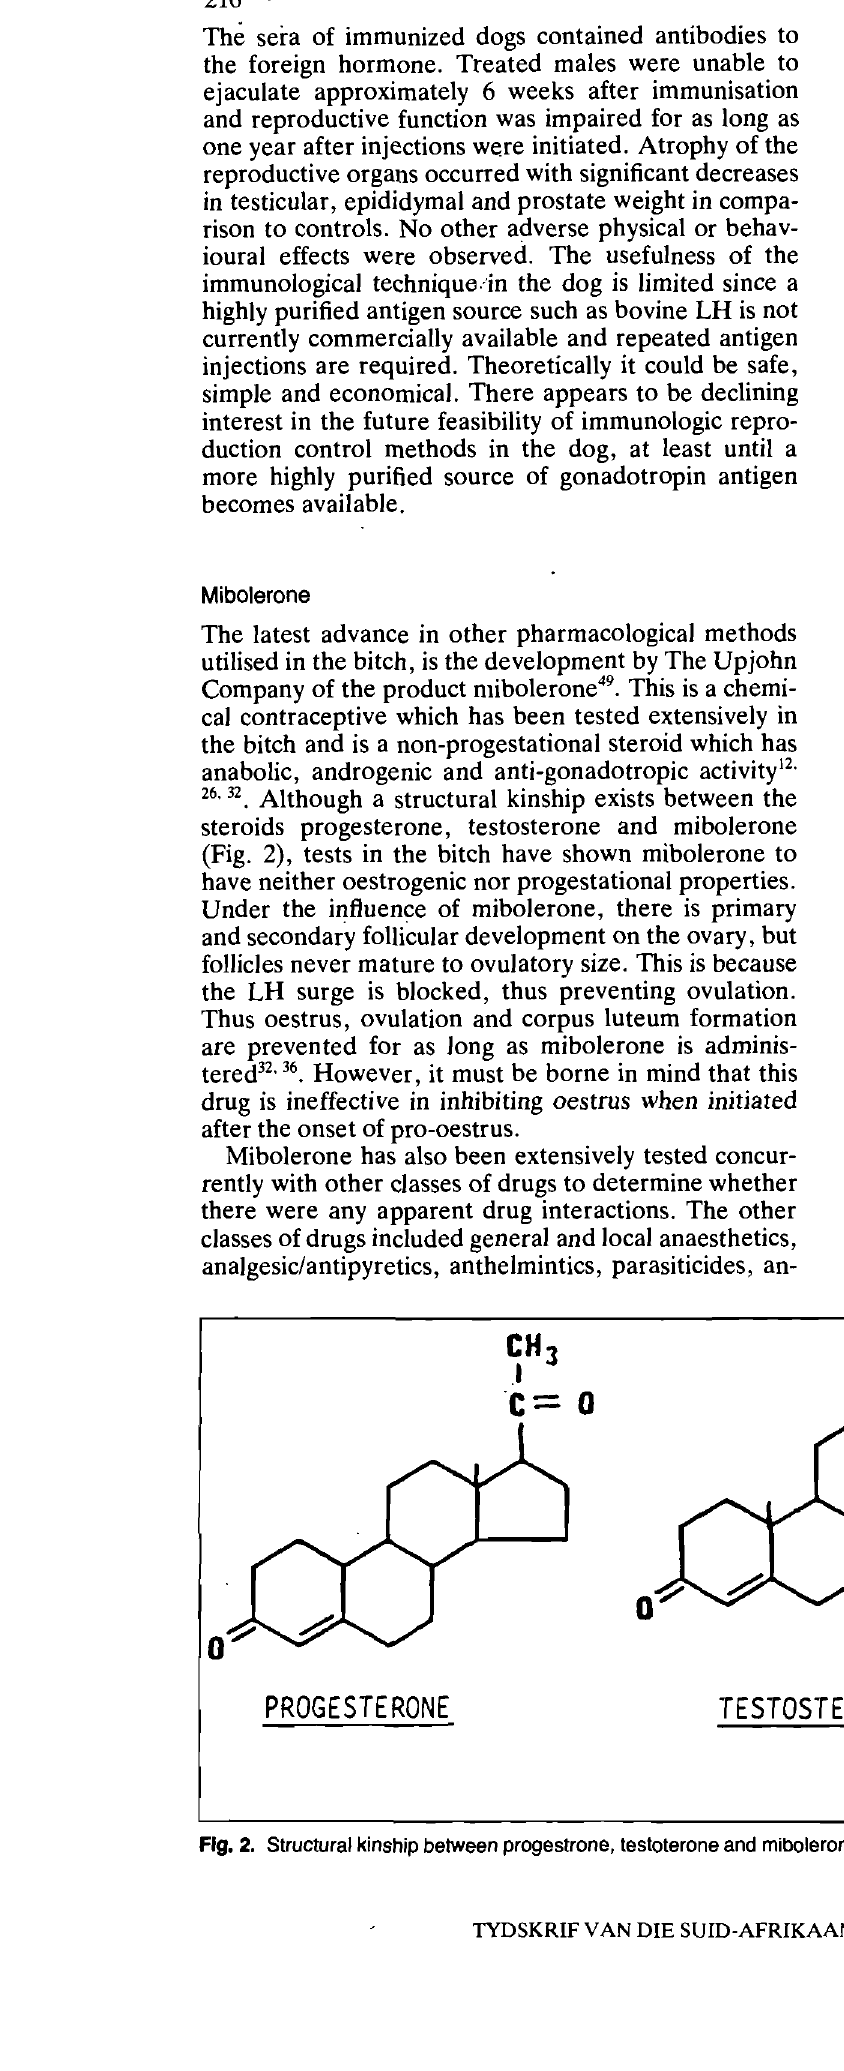
17-S-hydroxy-7a,17-dimethyl estr-4-en-3-one